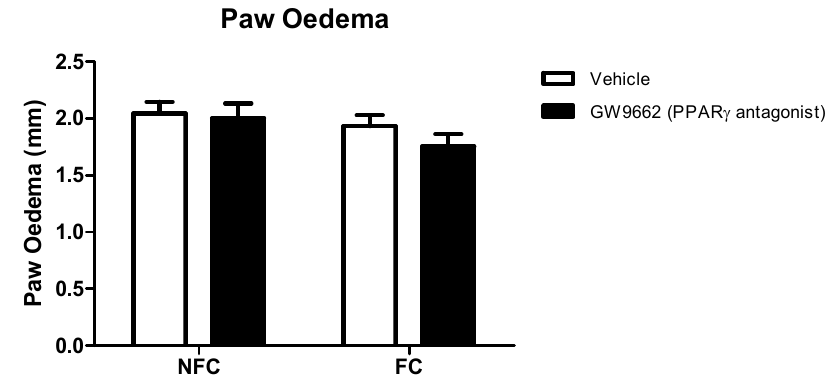
Figure 6. Effects of systemic administration of selective PPAR γ antagonist on formalin ‐ evoked hind paw oedema in non ‐ fear conditioned (NFC) and fear conditioned (FC) rats. Paw oedema was assessed by measuring the change in the diameter of the right hind paw immediately before, and 45 min after, formalin administration. Data are expressed as mean ± S.E.M, n = nine rats per group.